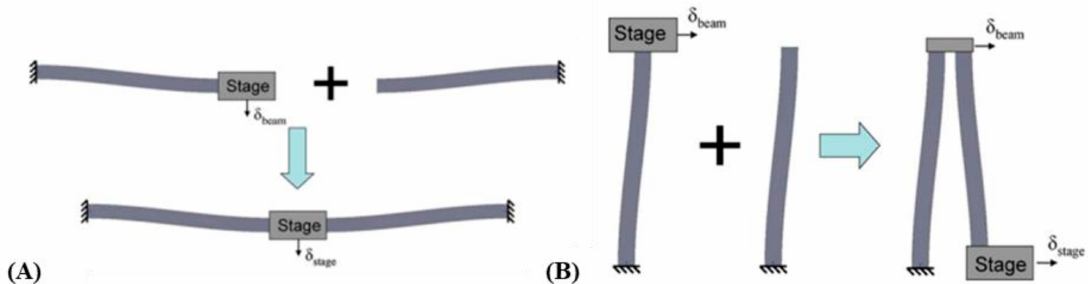
Figure 11. Example of a parallelogram flexure module used as a block for generating movement for each DOF [94]. ( A ) Single input-single output layout for a CM stage. ( B ) A multi-input-single output layout